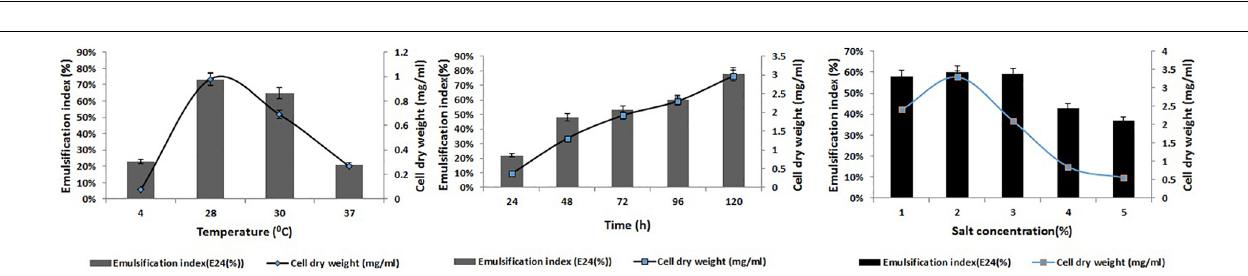
FIGURE 3 | Optimization of temperature, time, and salt concentrations for the production of the MSI 54